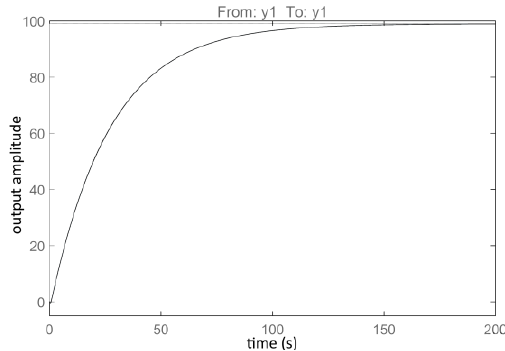
Figure 5. The step response of 𝐻 𝑃𝐶 (𝑞) [31].